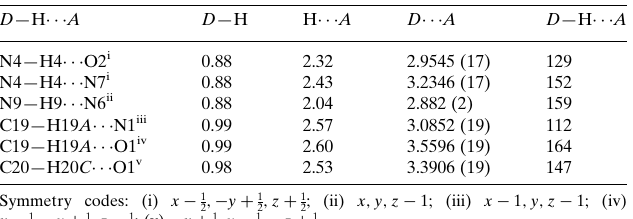
Hydrogen-bond geometry (A˚ , (cid:2)